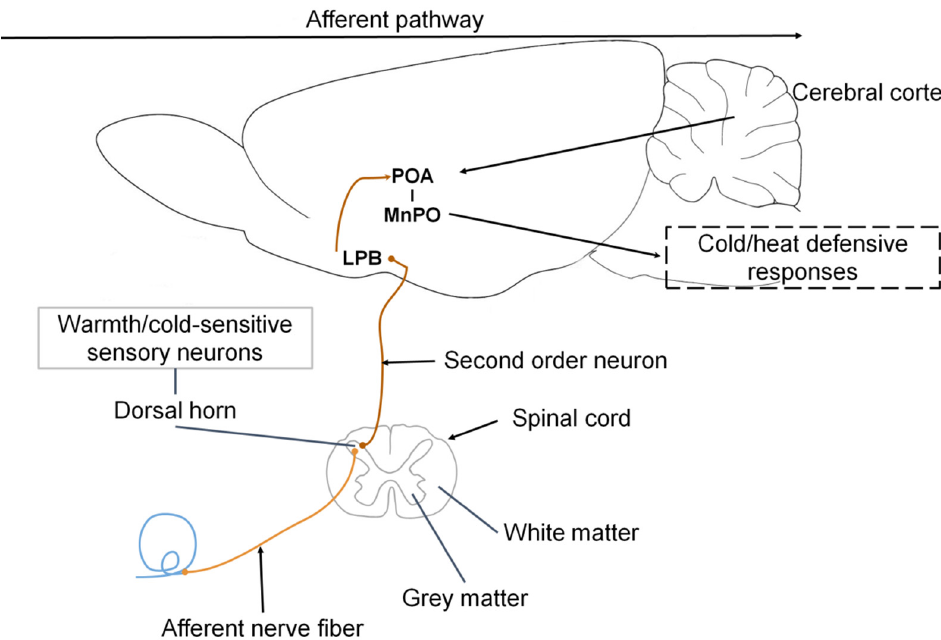
Figure 2. General mechanism of physiological thermoregulation in mammals. This process begins when the organism’s thermoreceptors in the skin detect a temperature change, either environ- mental or internal. Upon detecting the new temperature, those thermoreceptors transmit a signal through afferent nerve fibers to the dorsal horn of the spinal cord, where warm/cold-sensitive sensory neurons are activated. These neurons, in turn, transmit a response that consists of a nerve impulse sent to the lateral parabrachial nucleus (LPB) [63]. This triggers a reaction in the preoptic area (POA) of the hypothalamus—a structure considered responsible for thermoregulation in mammals [64]—specifically, the median preoptic nucleus (MnPO) [8]. After that, cold- or heat-defensive responses are initiated through efferent pathways [1]. Cutaneous vasomotor adjustments form part of the effector changes that maintain thermal comfort, mediating the transfer of heat by convection between the body’s core